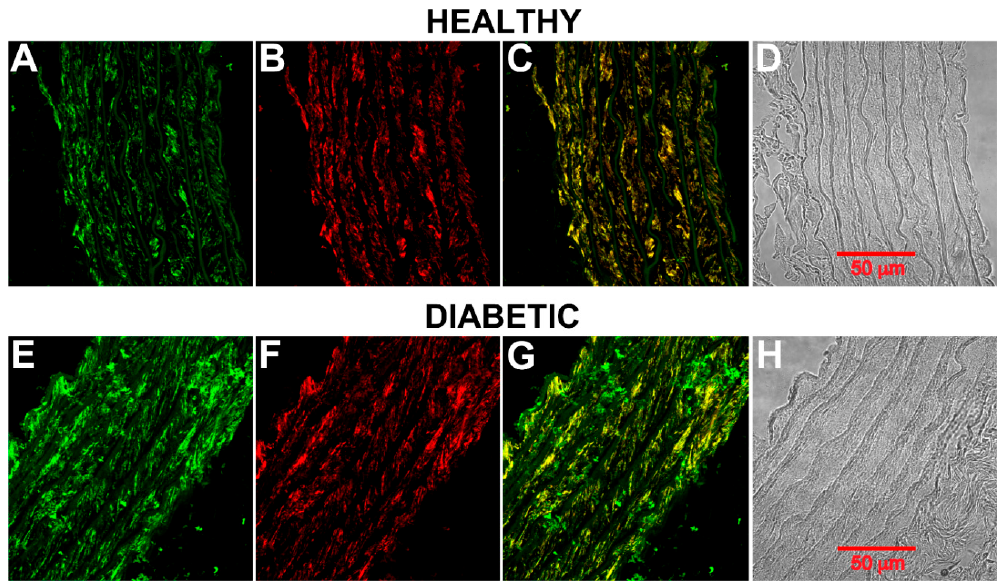
Figure 3. Phosphorylated CB 1 receptor on rat aortic smooth muscle. ( A ) Healthy rat aortic ring showing CB 1 receptor (green) and ( B ) smooth muscle α‐ actin (red). ( C ) An overlay of ( A ) and ( B ). ( D ) Bright ‐ field microscopy image of the aortic ring. ( E ) Diabetic rat aortic ring (8 weeks) showing CB 1 receptor (green) and ( F ) smooth muscle α‐ actin (red). ( G ) An overlay of ( E ) and ( F ). ( H ) Bright ‐ field microscopy image of the aortic ring.